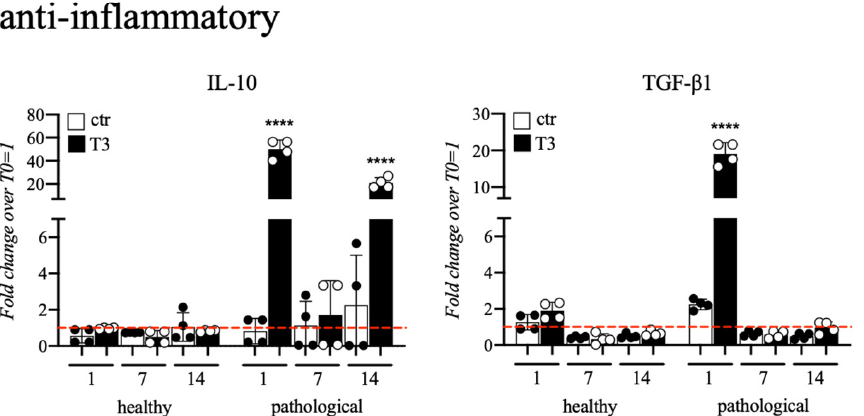
Figure 7. Gene expression profile for pro-/anti-inflammatory cytokines of tendon stem/progenitor cells (TSPCs) cultured in a medium supplemented with T3 (10 − 6 M) up to 14 days. Compared to healthy cells, the ones extracted from pathological tendons showed an impaired cytokines balance. Results are shown as mean ± SD. *** p < 0.001 and **** p < 0.0001 (N = 4).